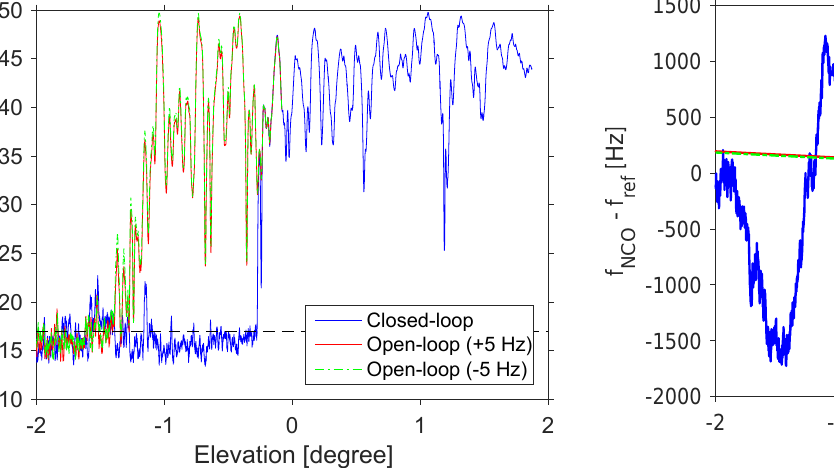
Figure 2. Observed signal-to-noise density ratio C /N 0 as a func- tion of geometric satellite elevation angle. Atmospheric bending amounts to about 1 to 2 ◦ at the observation site and therefore the two open-loop channels (green and red) continue to track the signal down to elevation angles of about − 1 . 2 ◦ . A strong amplitude fluc- tuation at about − 0 . 26 ◦ causes the closed-loop channel (blue) to lose tracking lock much earlier than the open-loop channels (green and red). A C /N 0 value of about 17dBHz is marked in black. Constructive interference produce high C /N 0 values exceeding 48dBHz at elevations below − 1 ◦ . This observation of GPS PRN 7 was recorded on 1 January 2015 between 06:38 and 06:52GPS time.